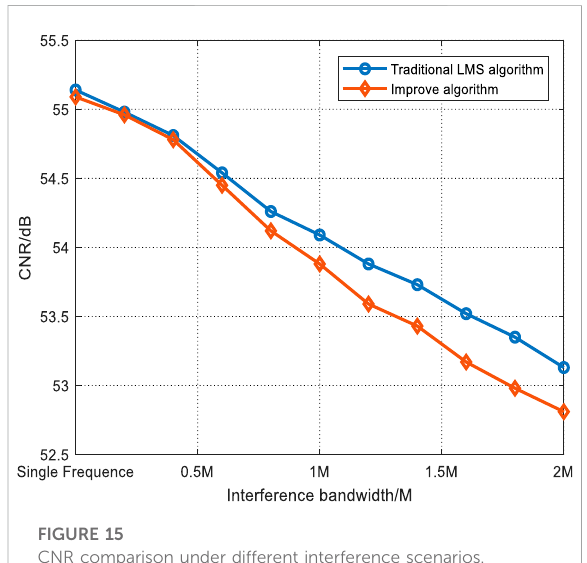
FIGURE 15 CNR comparison under different interference